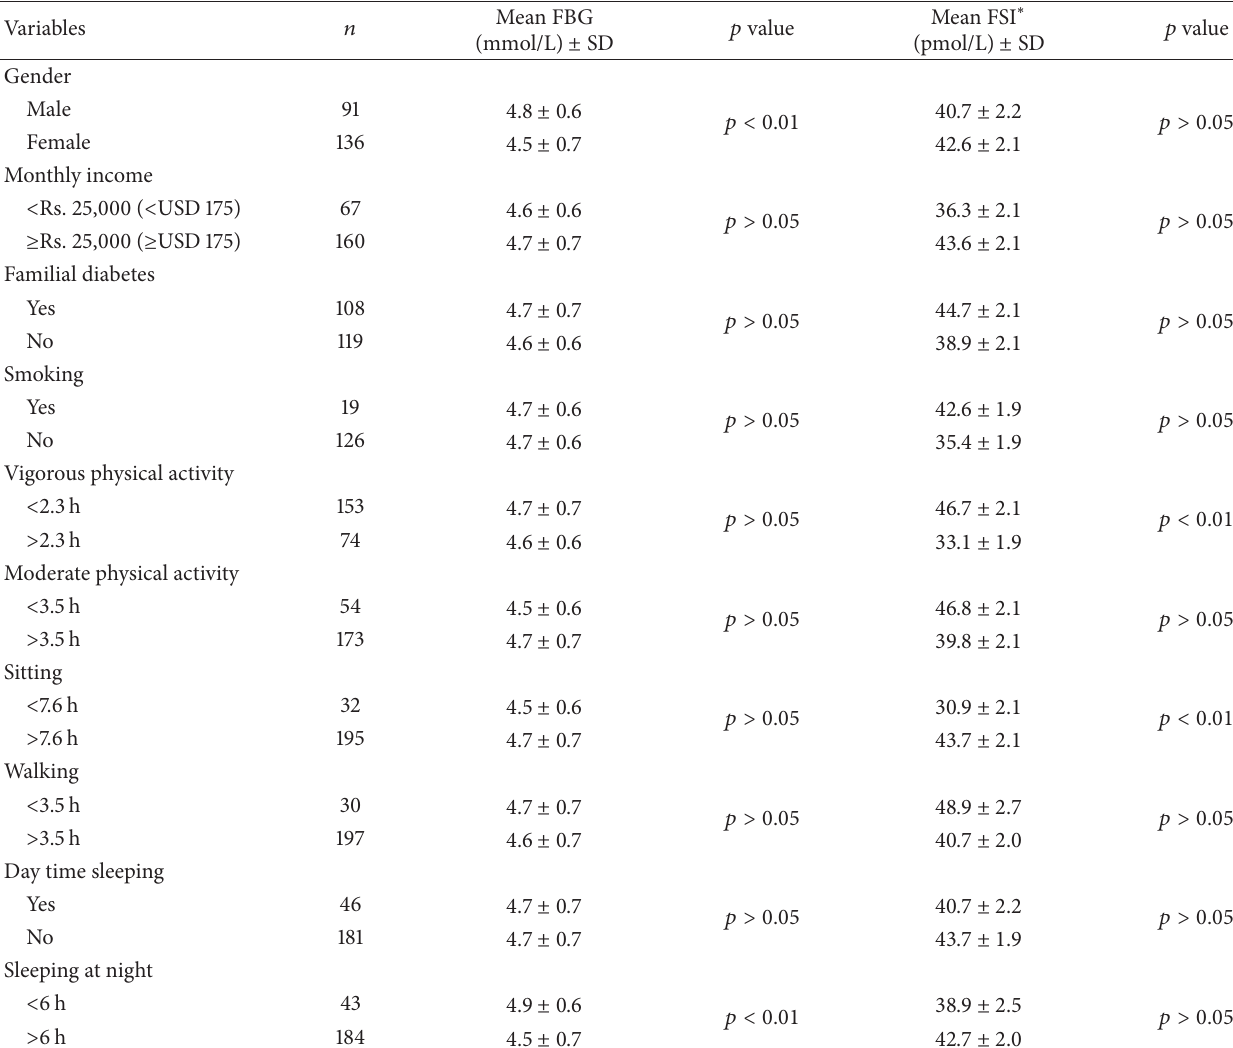
Table 4: Comparison of FBG and FSI among different groups in categorical variables in total study population † .